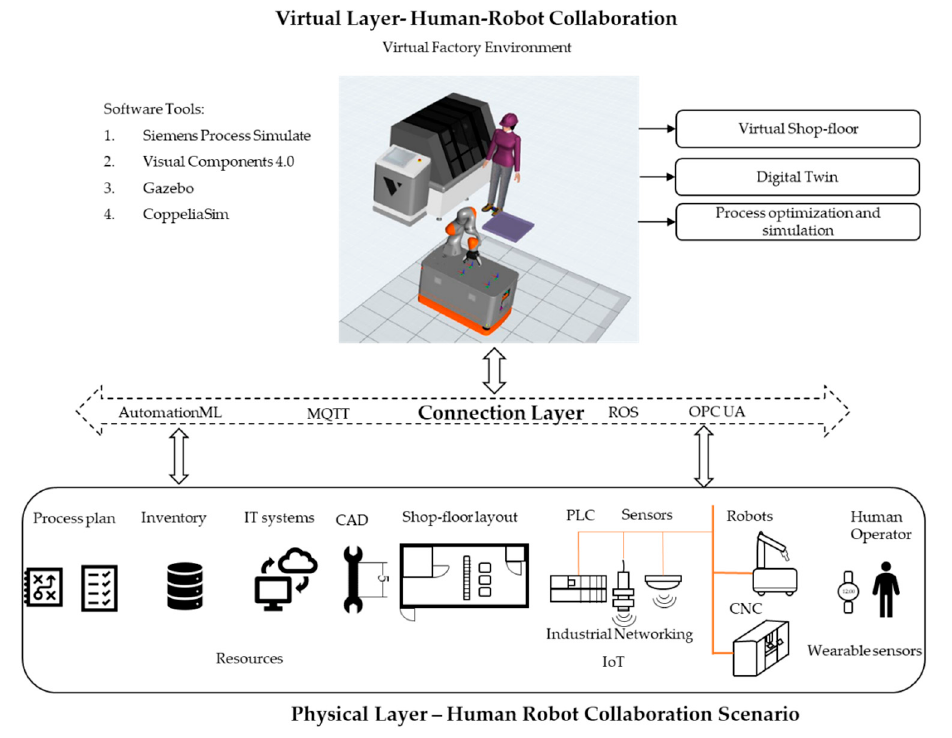
Figure 6. Layer-based approach for modelling of DT in HRC scenario.